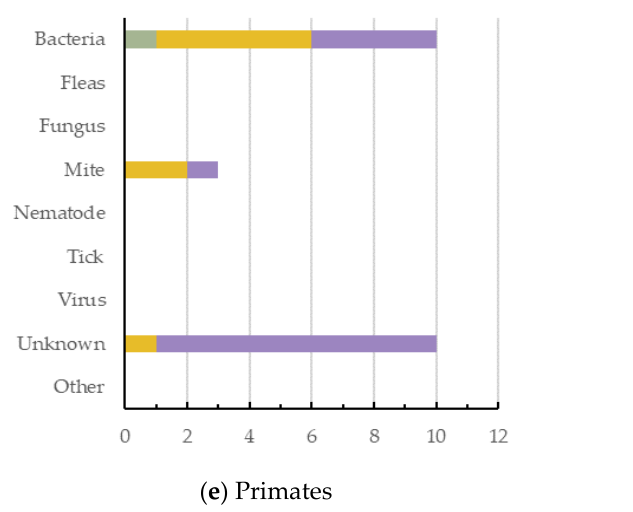
Table 4. International Union for Conservation of Nature’s (IUCN) Red List of threatened wild mammal species reported as having dermatitis. The 23 species categorized as ‘Critically Endangered’ (CR), ‘Endangered’ (EN), and ‘Vulnerable’ (VU) are shown, including their order and total number of cases. The number of dermatitis cases within endemic ecozones are shown for each species and the number of cases within non-endemic ecozones. Both ecozone categories are separated into the following captivity statuses of: Wild Captive (WC), Wild Free-living (WFL) and Wild Laboratory (WL). * WFL has one reported case within a non-endemic ecozone (*), and WL has no reported cases across non-endemic ecozones, so the columns have been removed to simplify the table.